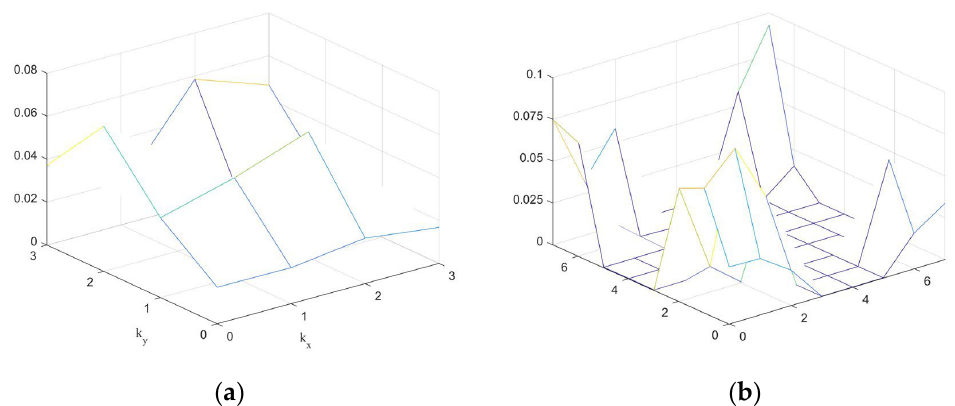
Figure 5. Angular spectrums before and after smoothing: ( a ) Original angular spectrum; ( b ) regen- erated angular spectrum.